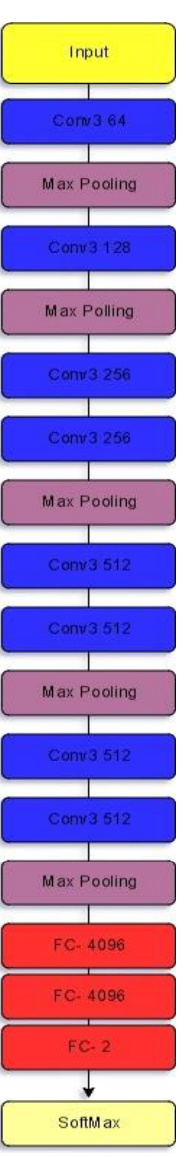
Figure 1. VGG-11 architecture.